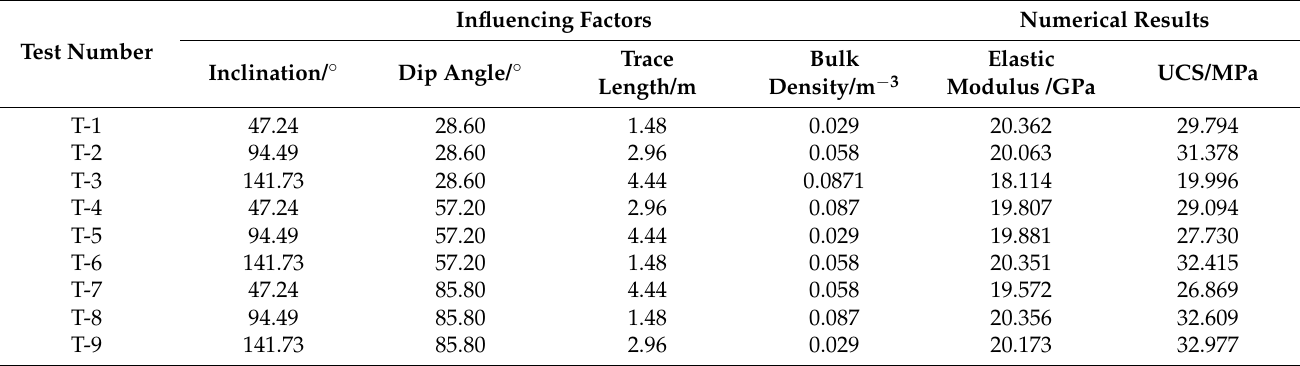
Table 4. The elastic modulus and UCS under various influencing factors and levels.